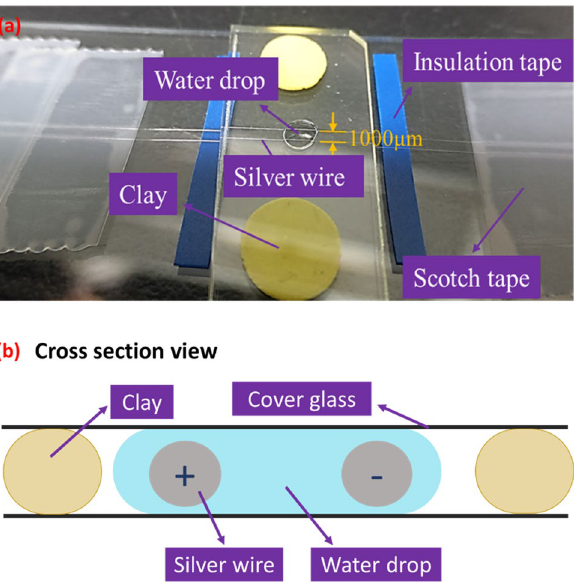
Figure 1. ( a ) The setup of the electrolytic process. ( b ) The silver wires were arranged at a 1000 µm distance from each other and fixed with Scotch tape. The cover glass plate on top of the silver wires was fixed on the sample holder with clay to maintain the stand-off. A drop of deionized water underneath the glass plates surrounded the two silver wires. The two silver wires served as the cathode and anode, respectively. The waster drop region between the two silver wires was observed under an optical microscope during electrical current stressing. A CCD camera was equipped to take a video of the